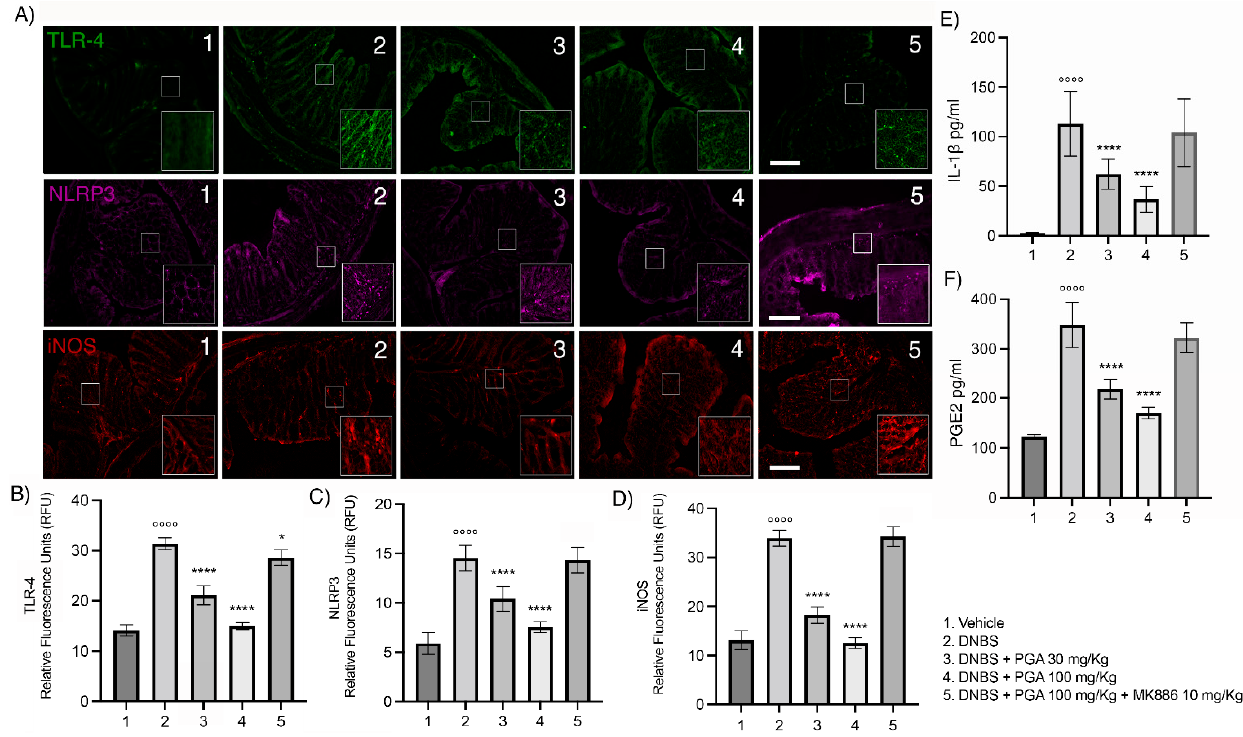
Figure 3. Micronized PGA decreases TLR-4/NLRP3/iNOS expression in mice colon and pro-inflammatory cytokines release in plasma samples throughout selective PPAR- α involvement in DNBS-treated mice. ( A ) Immunofluorescence images display TLR-4 (green), NLRP3 (magenta), and iNOS (red) staining, and the relative quantification for ( B ) TLR-4, ( C ) NLRP3, and ( D ) iNOS. ( E ) IL-1 β and ( F ) PGE 2 release in mice plasma. Results are expressed as the mean ± SD of n = 5 experiments (25 slices for each animal). ◦◦◦◦ p < 0.0001 vs. vehicle; * p < 0.05 vs. DNBS; **** p < 0.0001 vs. DNBS. Scale bar = 100 µ m; magnification 20 × 40 × . Toll-like receptor (TLR)-4; nucleotide-binding oligomer- ization domain leucine-rich repeat and pyrine domain-containing protein 3 (NLRP3);